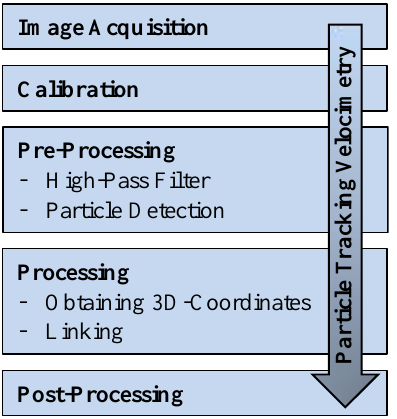
Figure 1. Workflow process of the 3D particle tracking velocimetry (PTV) algorithm to assess the displacement of tracer